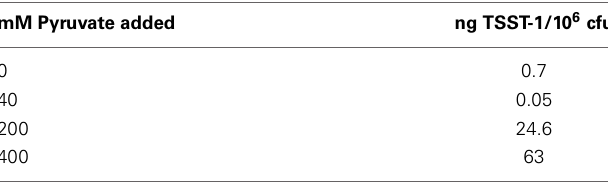
Table 1 | Anaerobic production of toxic shock syndrome toxin –